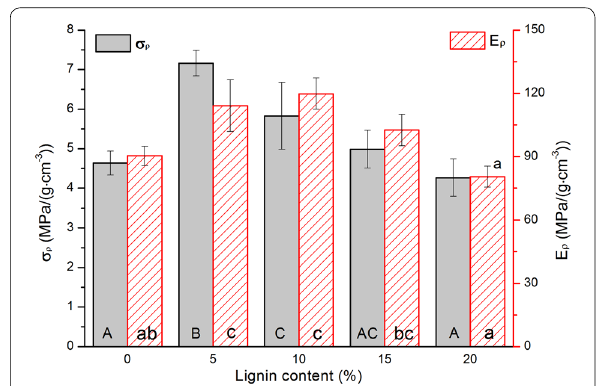
Fig. 5 Specific compressive strength ( σ ρ ) and modulus ( E ρ ) of the PU foams containing varying contents of lignin perpendicular to foam rise. Different letters represent statistically significant difference between groups ( p < 0.05)